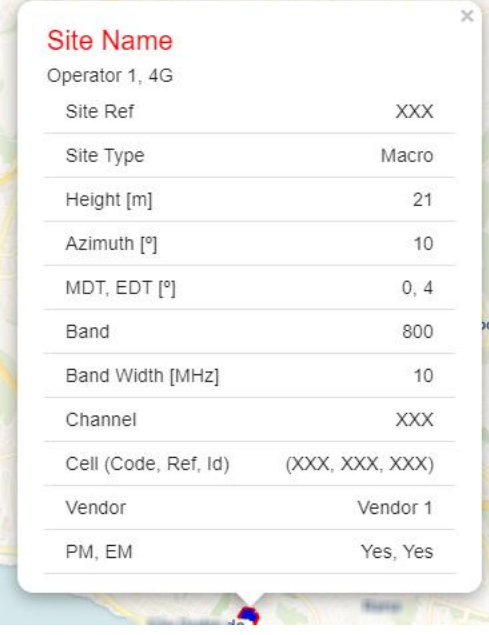
Figure 6. Panel with cell